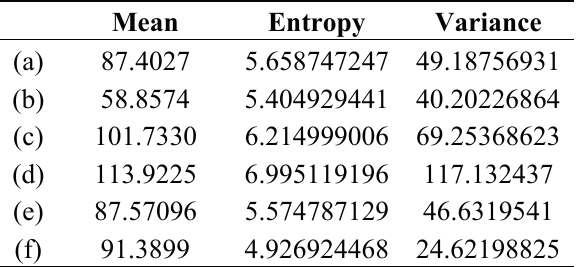
Table 1. Mean, entropy, and variance values of six images in Figure 6.